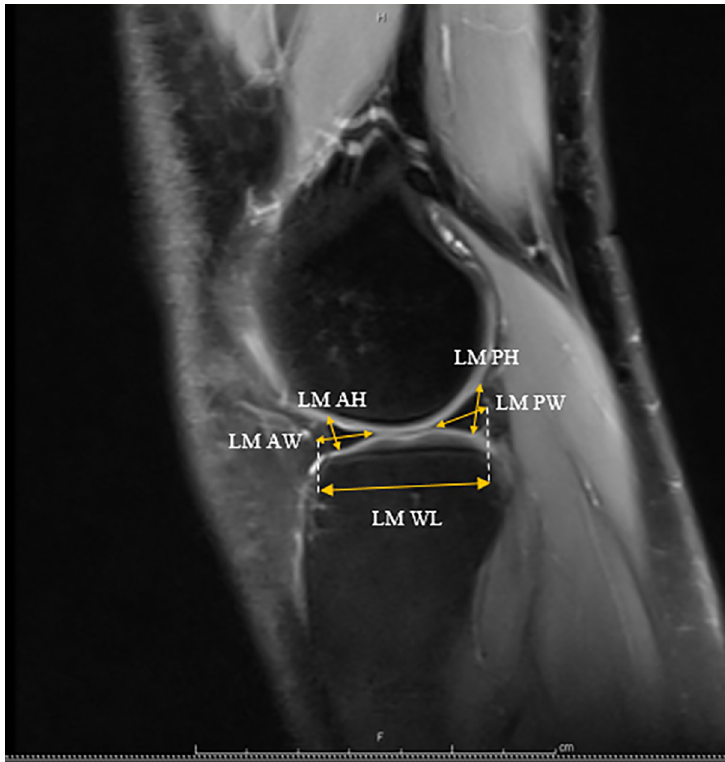
Fig 3. Mid-lateral sagittal section (LM AH) Lateral Meniscal Anterior height, (LM AW) Lateral Meniscal Anterior Width (LM PH) Lateral Meniscal Posterior Height (LM PW) Lateral Meniscal Posterior Width (LM WL) Lateral Meniscal Whole